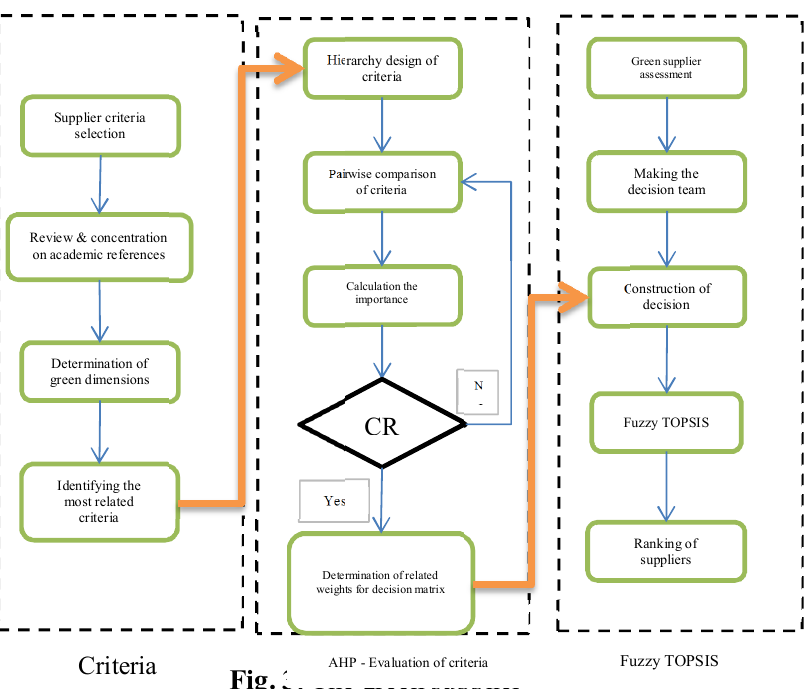
Fig. 3. The green supplier selection